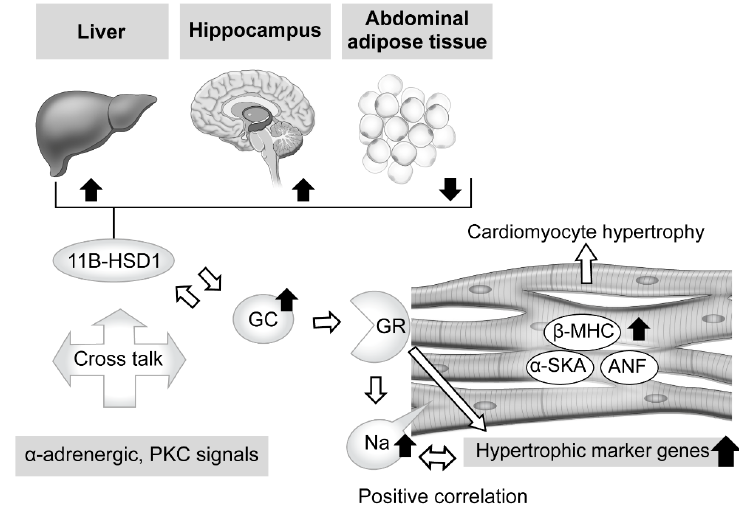
Figure 1. Effects of excessive glucocorticoid in cardiomyocytes and modulators of its signaling, including tissue-dependent regulation of 11 β -hydroxysteroid dehydrogenase type 1. Excessive glucocorticoid (GC) enlarged the cell size of rat cardiomyocytes, with elevation of cardiomyocyte hypertrophic markers and related genes, such as atrial natriuretic factor (ANF), β -myosin heavy chain ( β -MHC), and skeletal muscle α -actin ( α -SKA). The glucocorticoid receptor (GR) antagonist and knockdown of GR expression attenuated that reaction, whereas suppression of mineralocorticoid receptor (MR) activity did not, indicating an essential role for GR in such a response. Phenylephrine ( α -adrenergic receptor agonist) and phorbol ester (protein kinase C (PKC) activator), known to induce cardiomyocyte hypertrophy and related to hypertension and diabetes, potentiate the effects of corticosteroid and increase activated GR and MR expression. In addition, phorbol ester-induced hypertrophy exhibited increased 11 β -hydroxysteroid dehydrogenase type 1 (11 β -HSD1) expression and reductase activity. These results indicate possible cross talk between corticosteroid receptor- activated pathways, and both α -adrenergic and PKC signals. Corticosteroid also induces an increase in intracellular sodium concentration, which is related to ischemia, heart failure, and hypertrophy. That increase was revealed to have a positive correlation with hypertrophic gene expression. Fur- thermore, excessive corticosterone increased the expression level of 11 β -HSD1 mRNA in abdominal adipose tissue, while that was decreased in the hippocampus and liver, suggesting regulation in a tissue-dependent